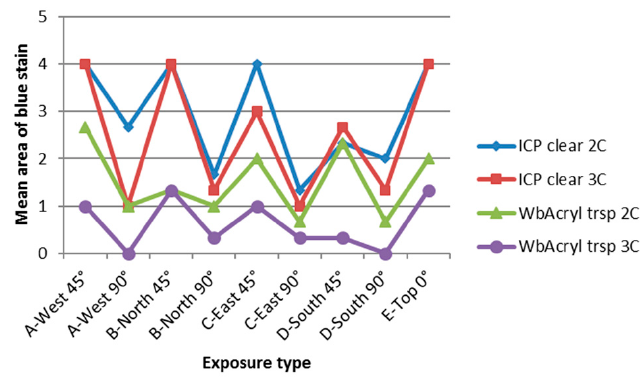
Figure 11. Mean area of blue stain after 12 months of exposure (August 2016) using the MFER.